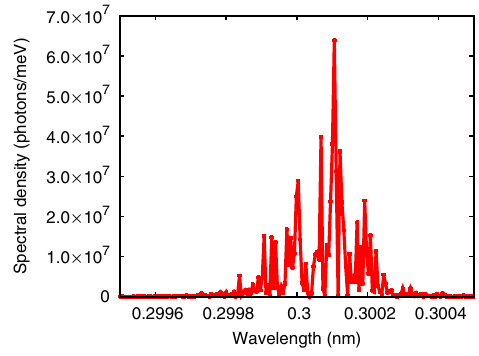
FIG. 16. Spectrum at saturation at a fundamental of 0.3 nm using an undulator period of 26